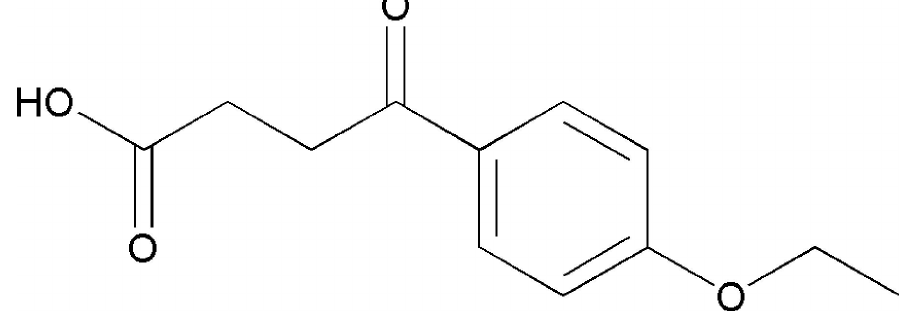
Figure 1 The molecular structure of the title molecule, with the atom-numbering